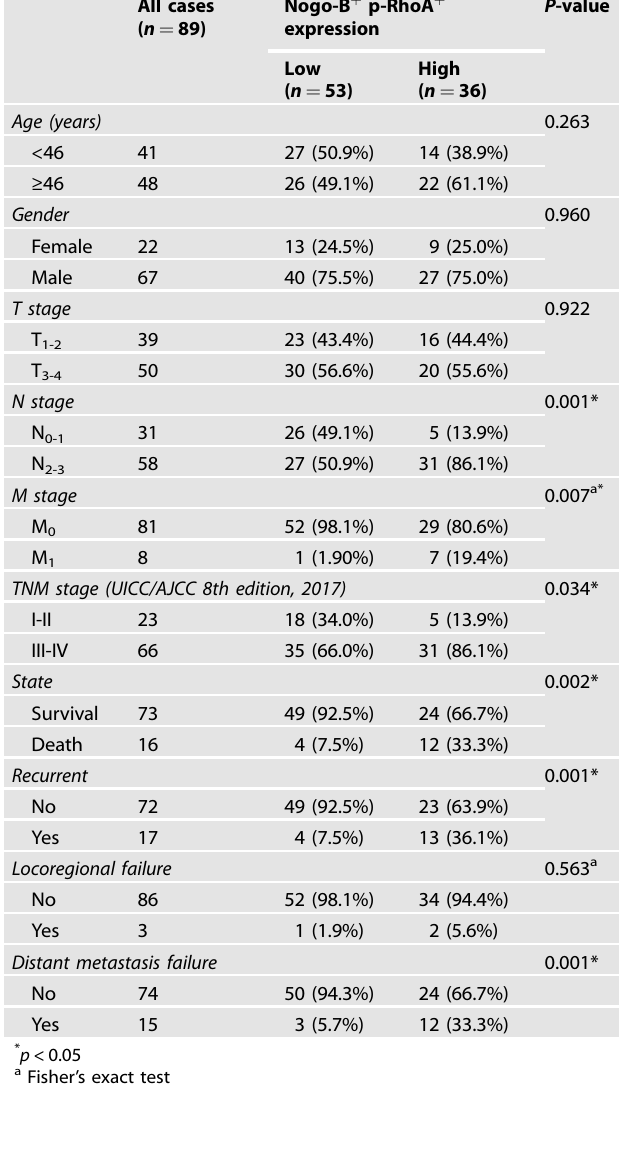
Table 3. Correlation between the expression of Nogo-B + p-RhoA + and the clinicopathologic features of NPC.